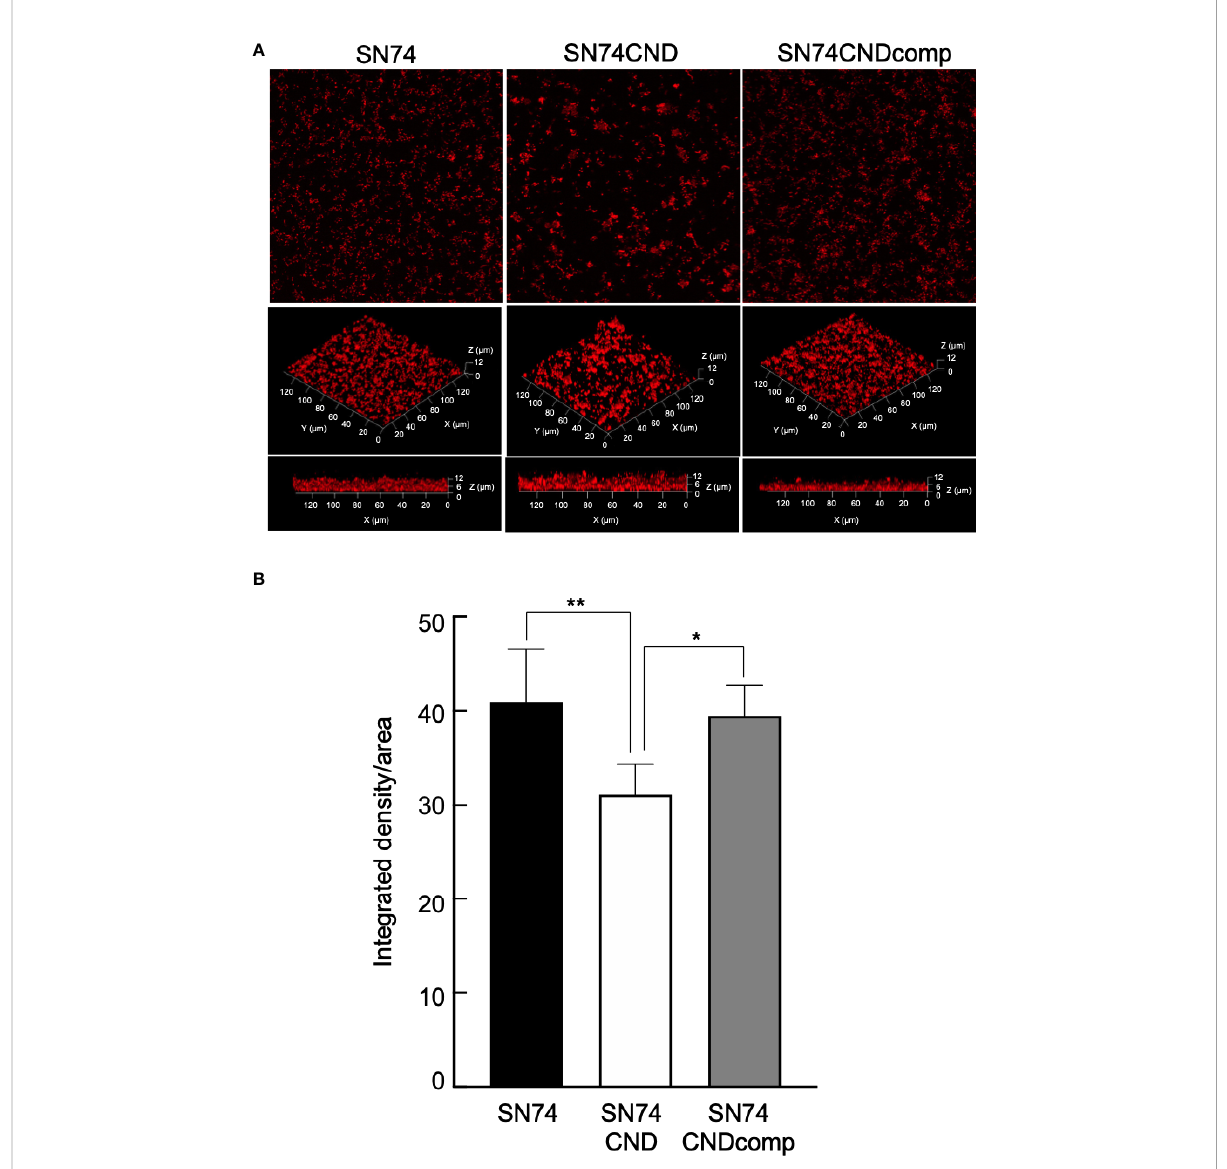
FIGURE 8 Observation of bio fi lm formation using confocal laser scanning microscopy (A) . Confocal laser scanning microscopic images of S. mutans strains SN74, SN74CND and SN74CNDcomp. (B) Densitometric analysis of bio fi lms generated by strains SN74, SN74CND, and SN74CNDcomp. Bio fi lm images for each sample were acquired using three random positions and three independent experiments were performed in triplicate for each strain. Data are presented as the mean ± SD. Statistical signi fi cance was determined using analysis of variance with Bonferroni ’ s correction. * P < 0.05; ** P <